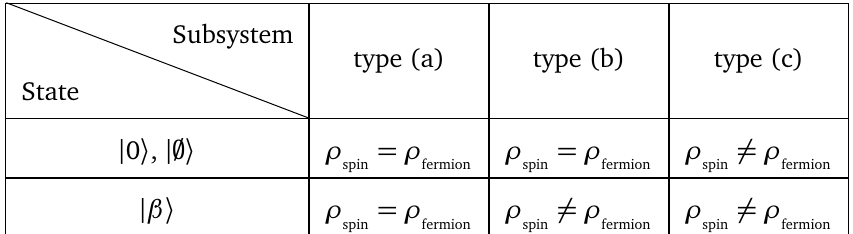
is the RDM in the fermion